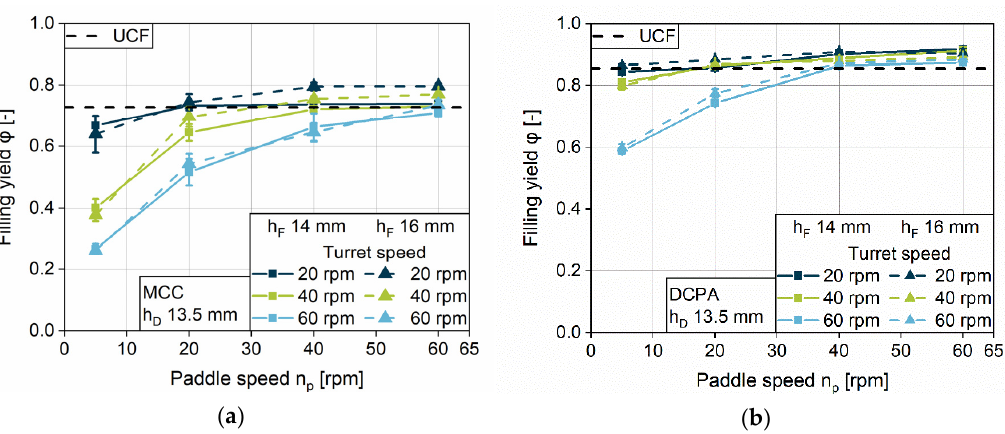
Figure 12. Impact of the paddle speed on the filling yield for ( a ) MCC and ( b ) DCPA with varying turret speed.